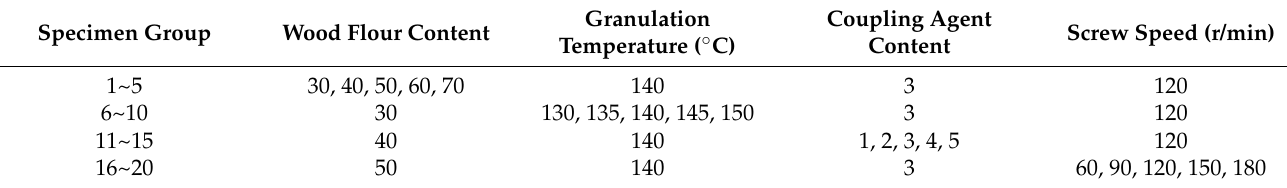
Table 1. Process parameters for each group of specimens required for the